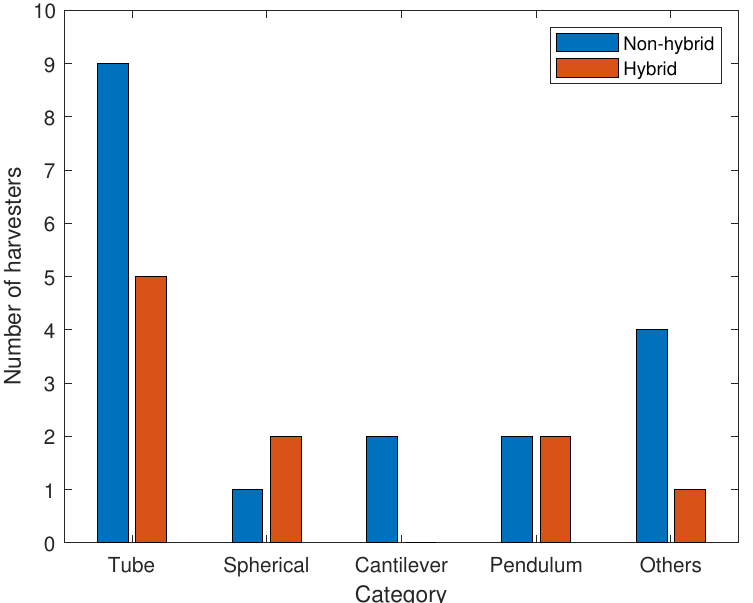
Figure 9. Bar graph with 3D printed EM hybrid and non-hybrid vibration harvesters grouped into